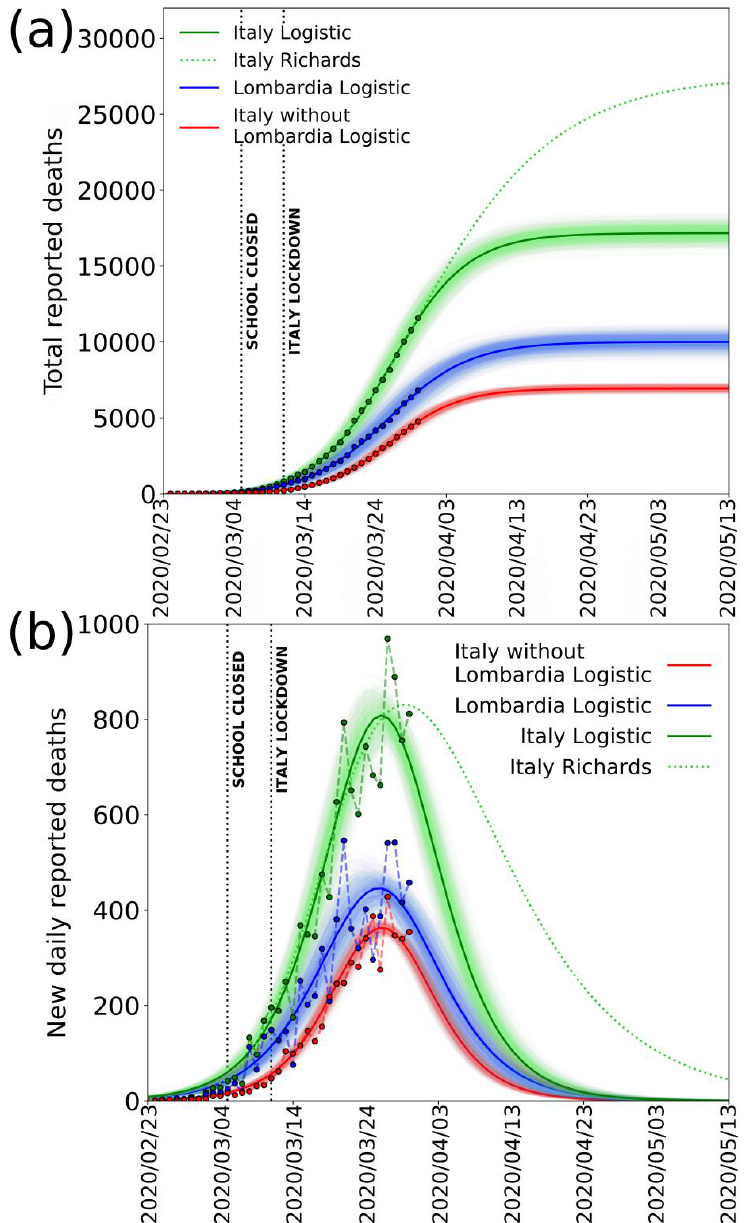
Figure 3. Deaths reported by Italian Civil Protection. ( a ) Total deaths reported in Italy (green dots), Lombardia (blue dots), and Italy without Lombardia (red dots) from 24 February to 30 March 2020 and the corresponding logistic fit in solid lines. Dotted vertical lines mark the dates of Italian school lockdown and Italy total lockdown. A sample best fitting Richards’ curve for the whole Italy is also shown (green dotted line). ( b ) Same as in ( a ) using the new daily reported deaths and fitting the derivate of the logistic and Richards’ curve. Shaded areas represent the family of curves obtainable by making the fit parameters vary within their confidence intervals. Fit parameters: − xr ( m − n ) e − xr Logistic ( y = K 1 + me ; Italy : K = ( 178 ± 4 ) · 10 2 , m = − 3.1 ± 0.5, n = 380 ± 30, ; Logistic (cid:48) : Kr 1 + ne − xr ( e rx + n ) 2 r = 0.183 ± 0.004); Lombardia : K = ( 100 ± 4 ) · 10 2 , m = − 2.8 ± 0.5, n = 270 ± 30, r = 0.176 ± 0.006 ) ; Italy without Lombardia : K = ( 74 ± 2 ) · 10 2 , m = − 4.0 ± 0.8, n = 740 ± 60, r = 0.201 ± 0.004;